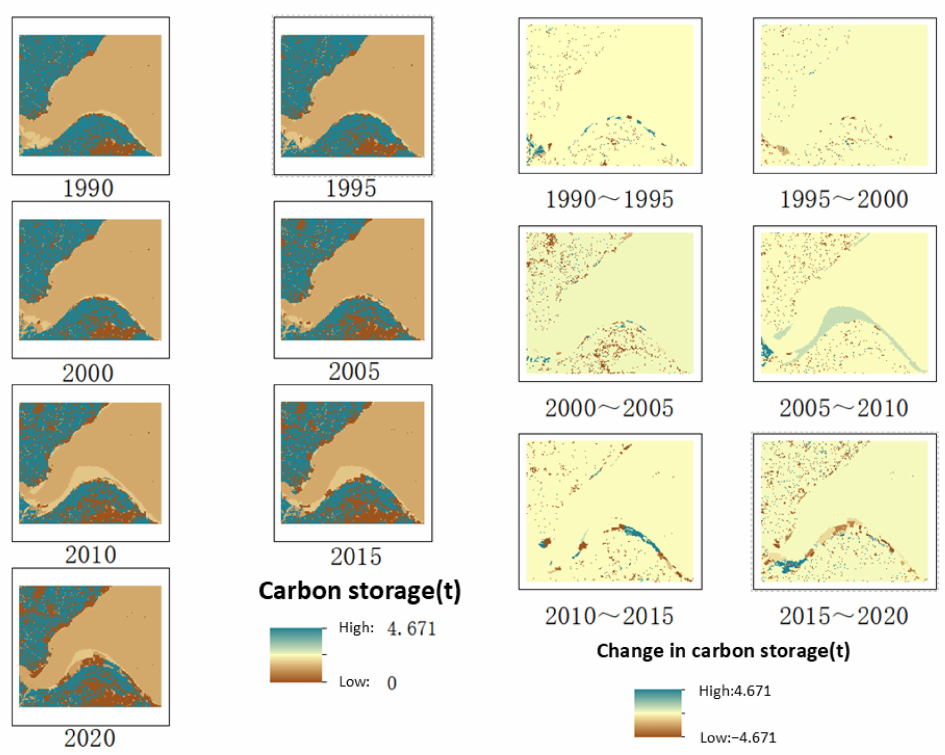
Figure 4. Carbon storage distribution and changes every five years in the Hangzhou Bay wetlands from 1990 to 2020. The left graphs show the regional distribution of carbon storage in the study area each year. The right graphs show the regional distribution of changes between five